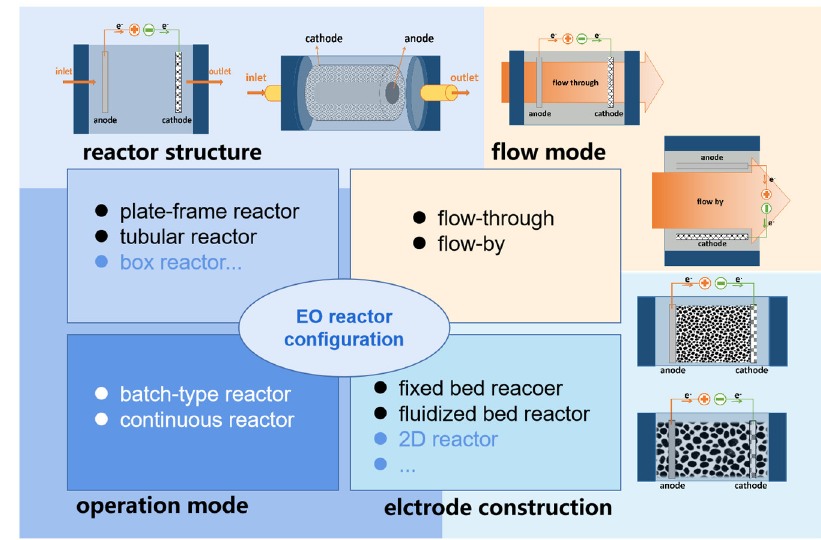
Figure 2. Reactor configurations of ECRs.